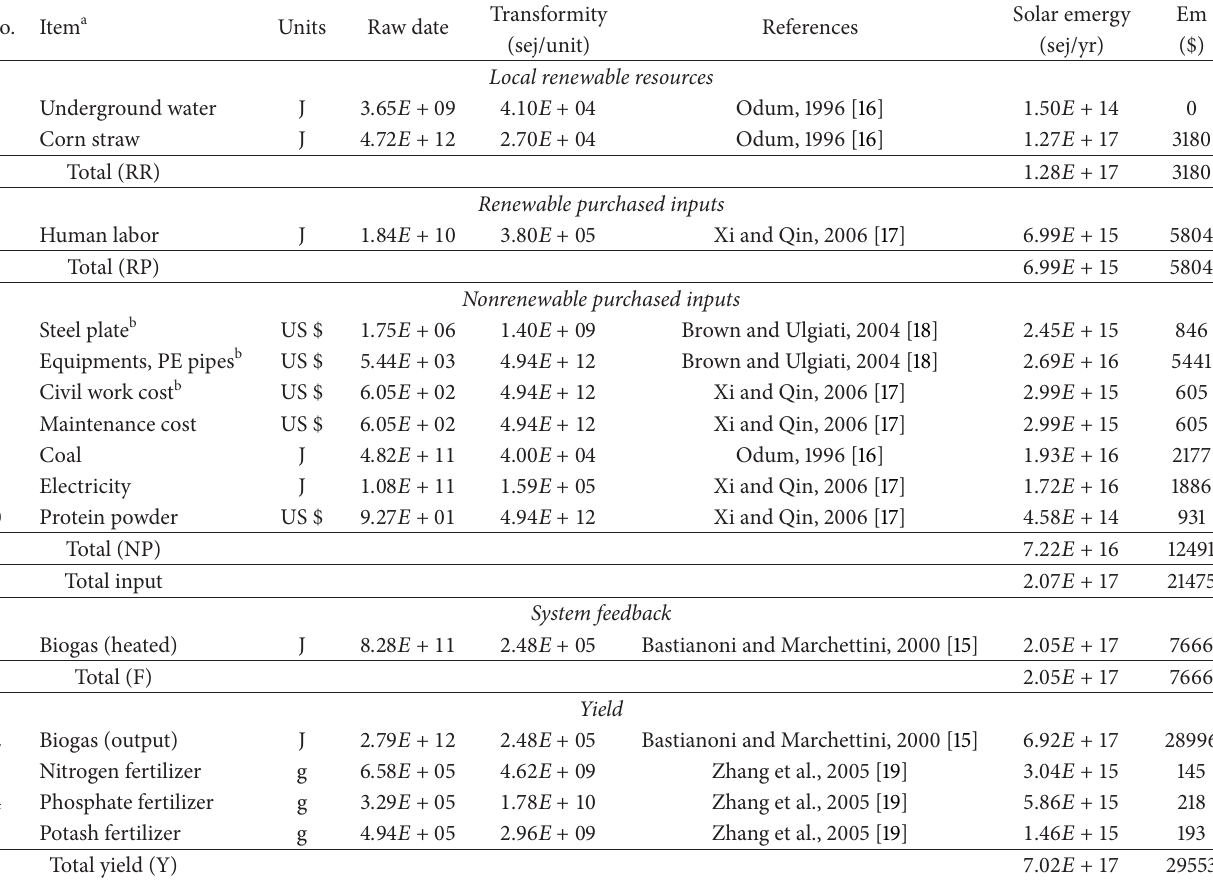
Table 1: Energy accounting for BPC system.